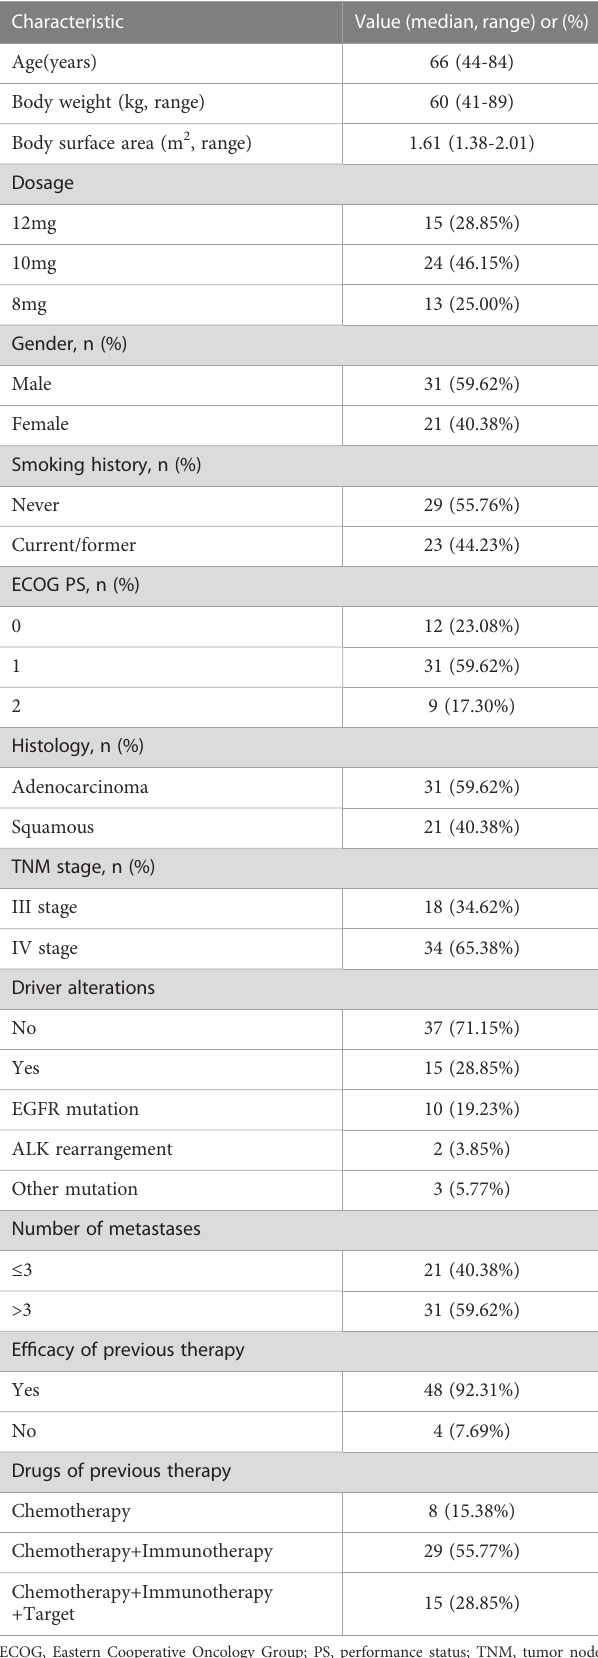
TABLE 1 Baseline characteristics of patients.